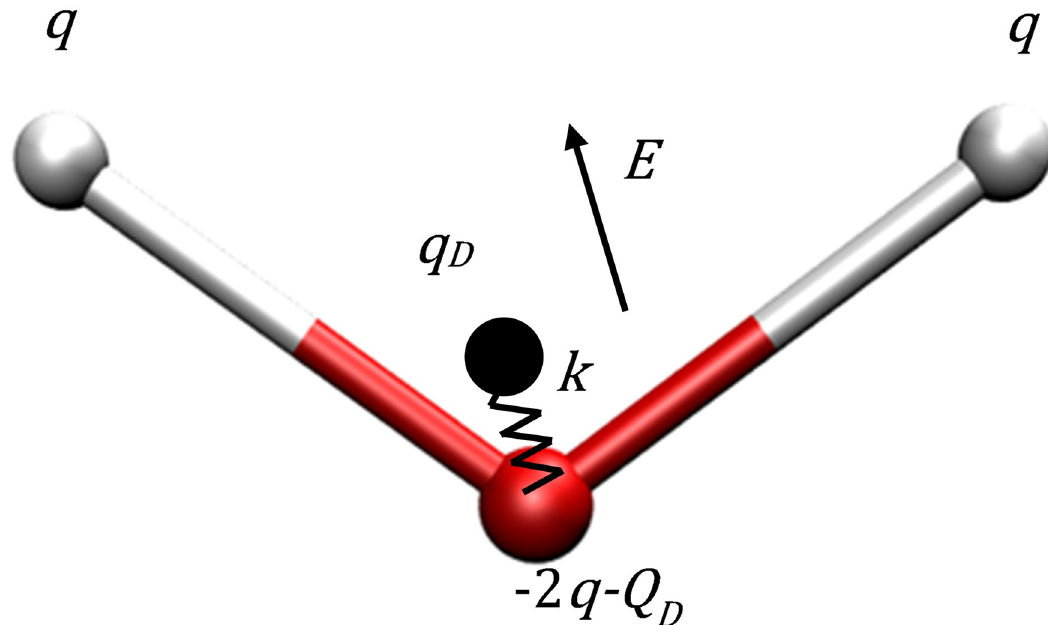
Fig 5. Schematic of a 3-point polarizable water model with Drude oscillator. This model is composed of three fixed point charges and a Drude oscillator particle attached to the Oxygen atom. Charge q is assigned to each white point as Hydrogen, charge ( − 2 q − Q D ) is assigned to the red point as Oxygen and the black point as the Drude particle has charge Q D and zero mass. The black point is connected to the red point through a virtual bond with equilibrium length 0, force constant k and no directional restrictions. An external electric field E moves the Drude particle from its equilibrium position